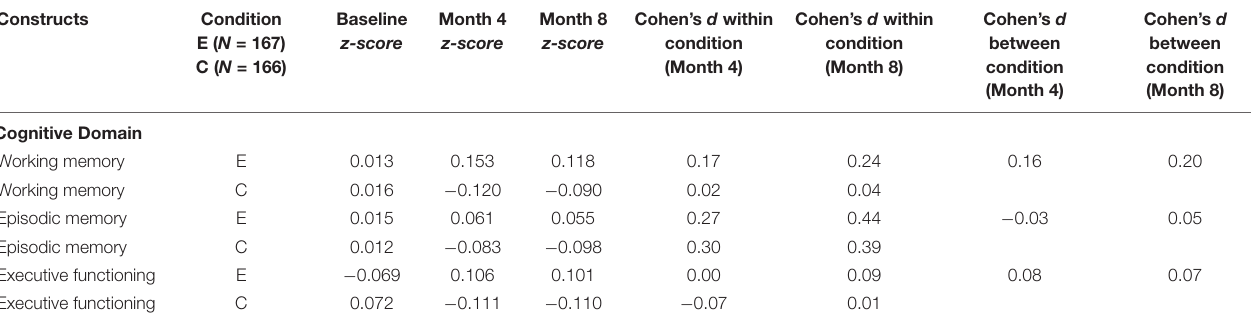
TABLE 2 | Means and standard deviations of cognitive domain scores by study condition, with effect sizes for within and between condition differences.